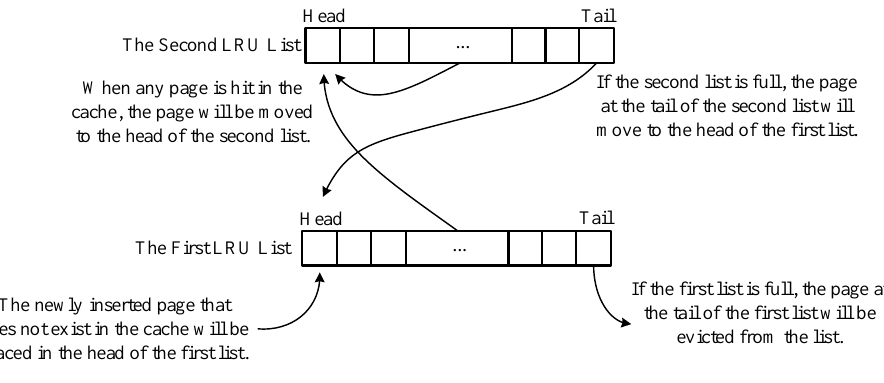
Figure 1. Two-Level LRU. 3.